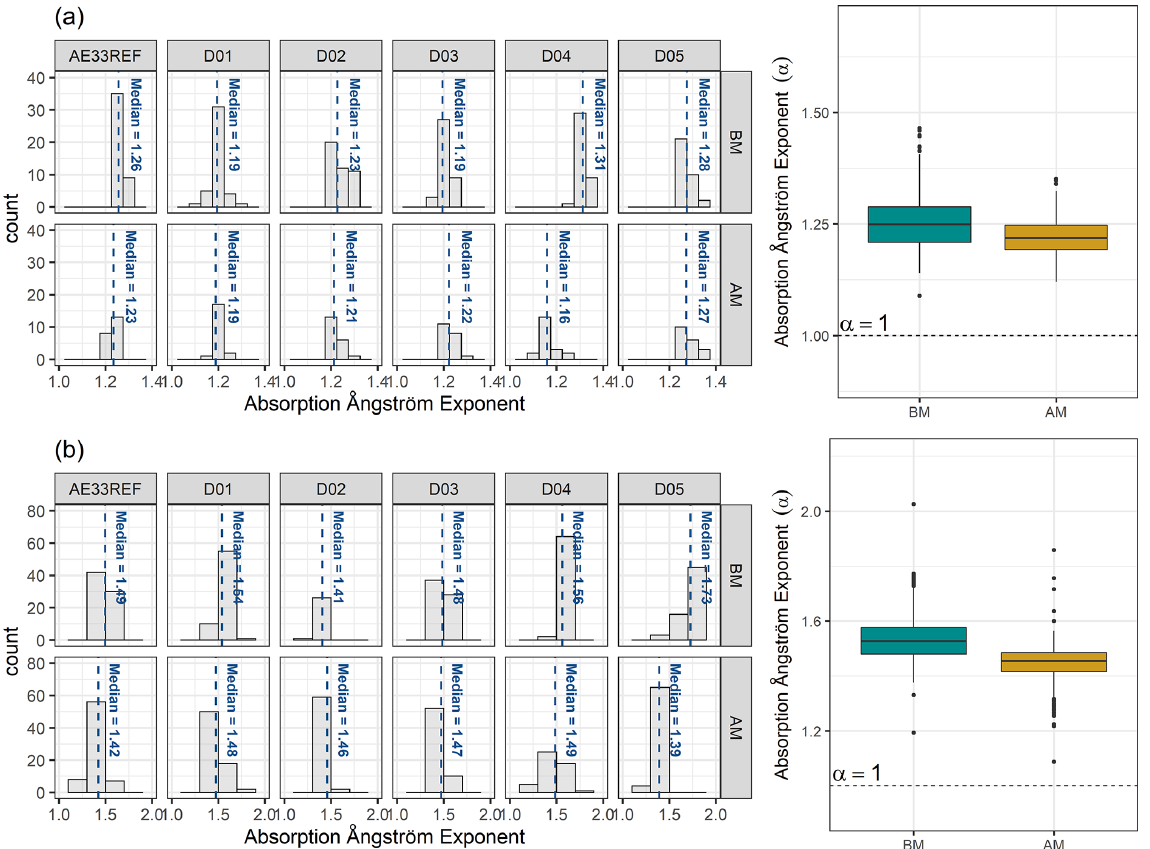
Figure 14. Absorption Ångström exponent ( α ) calculated using power law fitting of the absorption from 370 to 950nm for the instruments in group D and the reference Aethalometer before and after maintenance during measurements of (a) soot and (b) ambient air. BM: before maintenance. AM: after